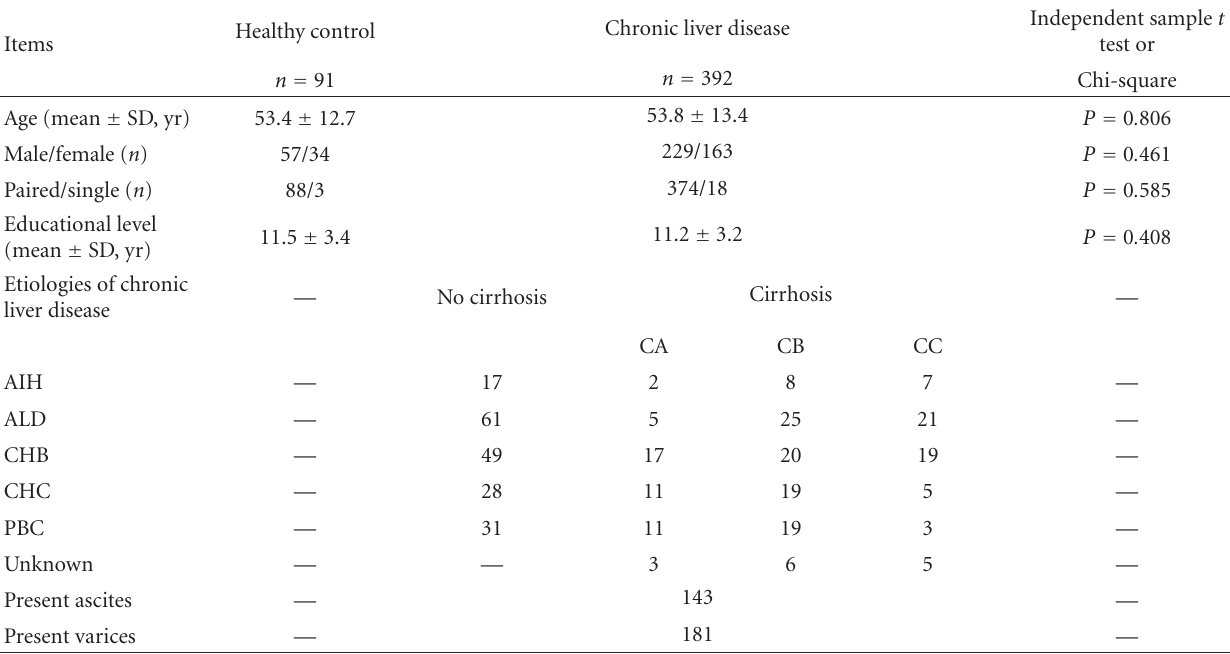
Table 1: Demographic data of di ff erent